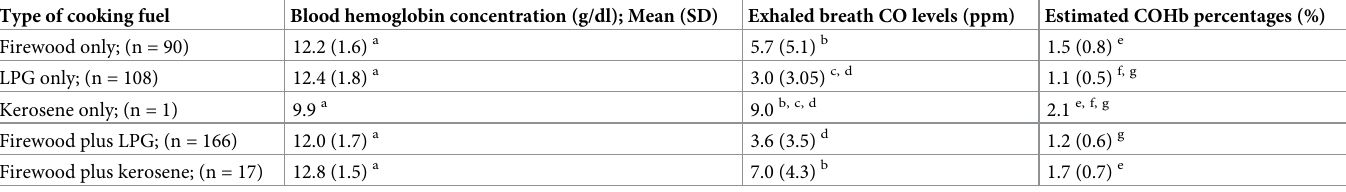
Table 3. Mean hemoglobin concentrations, exhaled breath CO levels and estimated COHb percentages across different cooking fuel type users. Type of cooking